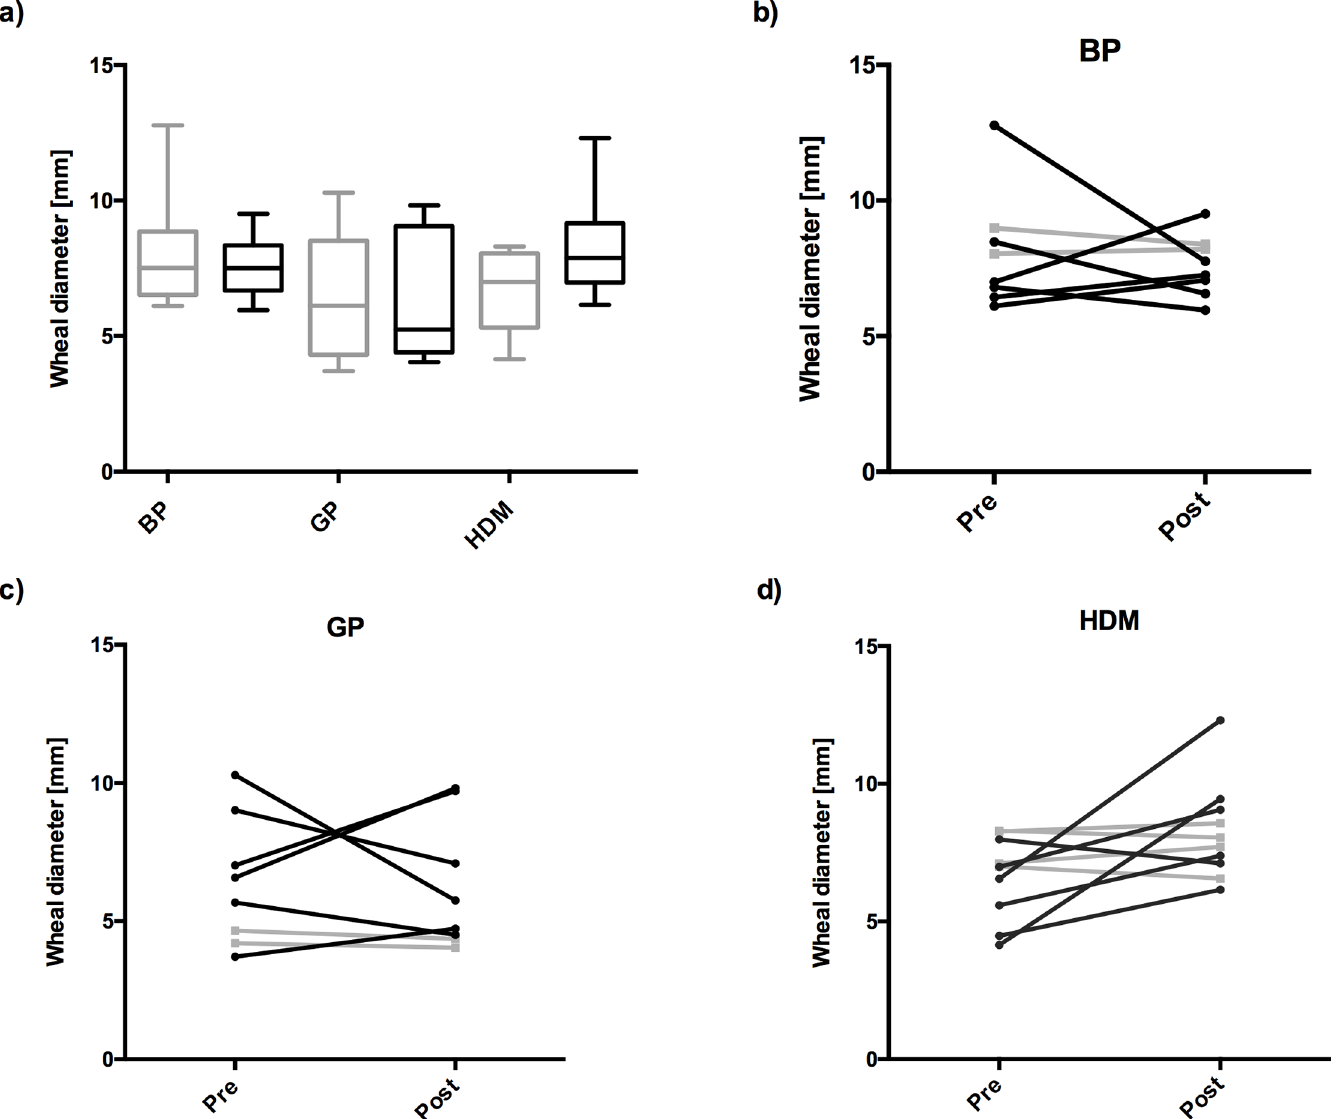
(n = 10), before (Pre) and after the TSST (Post); black lines in b)-d) indicate subjects responding with > 10% relative change of reactivity, grey: less than 10%